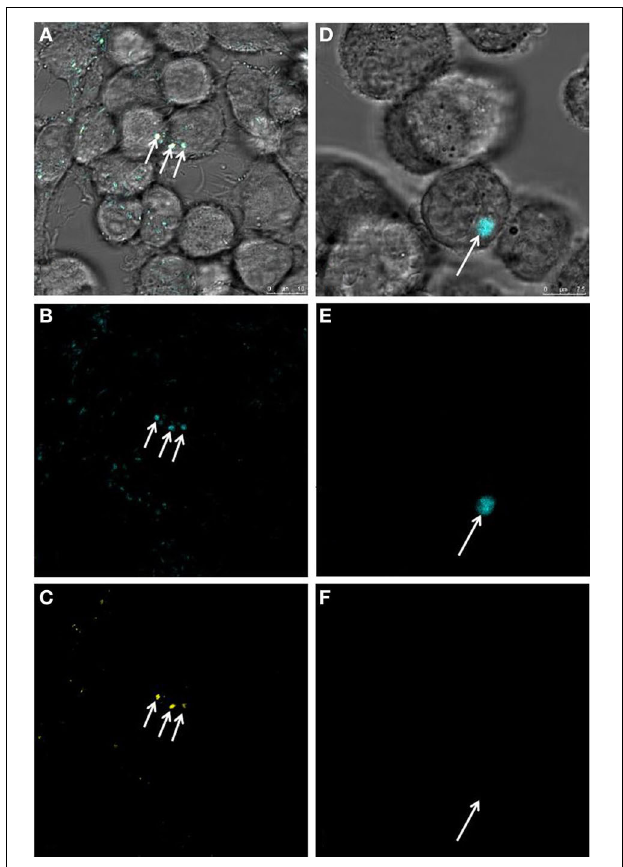
FIGURE 4 | Investigation of phagolysosomes (yellow) stained with a pH-sensitive dye for presence of L. monocytogenes -CFP parental, or L-form cells (blue). Superimposition of micrographs (A) shows co- localization of blue signals from heat inactivated parental L. monocy- togenes -CFP (B) with yellow signals (C) pointing to phagolysosomes harboring parental bacteria (white arrows). Superimposition of images (D) demonstrates presence of a blue signal from a L. monocytogenes L-form (E) and absence of a yellow signal (F) , suggesting that the intracellular L. monocytogenes -CFP L-form cell (white arrow) is not contained within a phagolysosome. Scale bars apply to the respective column of images.